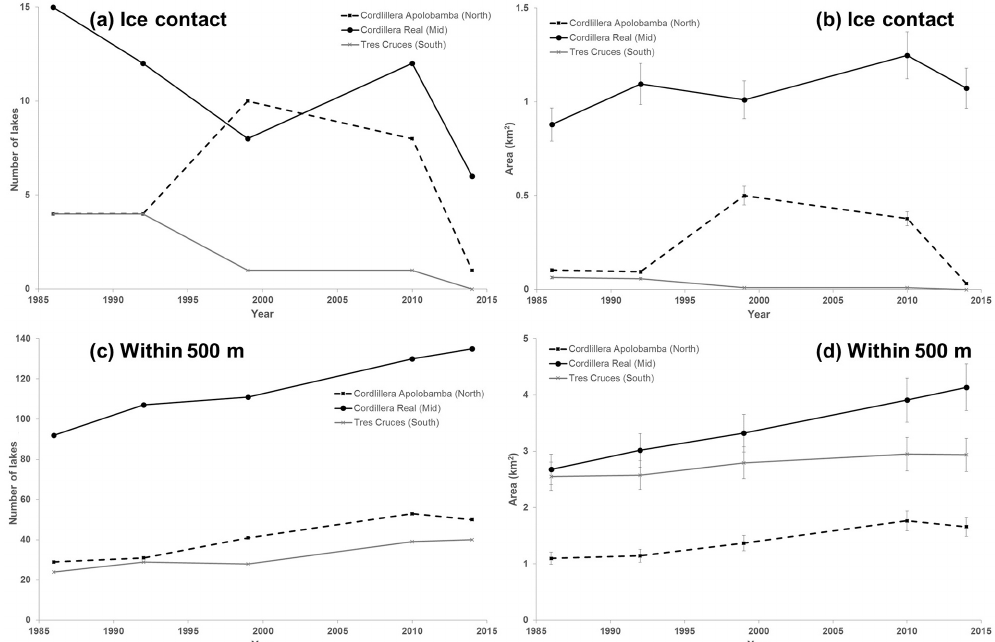
Figure 7. Proglacial lake evolution from 1986 to 2014 across the Cordillera Apolobamba (north), Cordillera Real (middle), and Tres Cruces (south) regions. The number and area of ice-contact lakes are shown in (a) and (b) respectively. The number and area of lakes within 500m of the 1986 ice margin are shown in (c) and (d) respectively. Error bars are determined using Eq. (1) and represent an uncertainty of ±